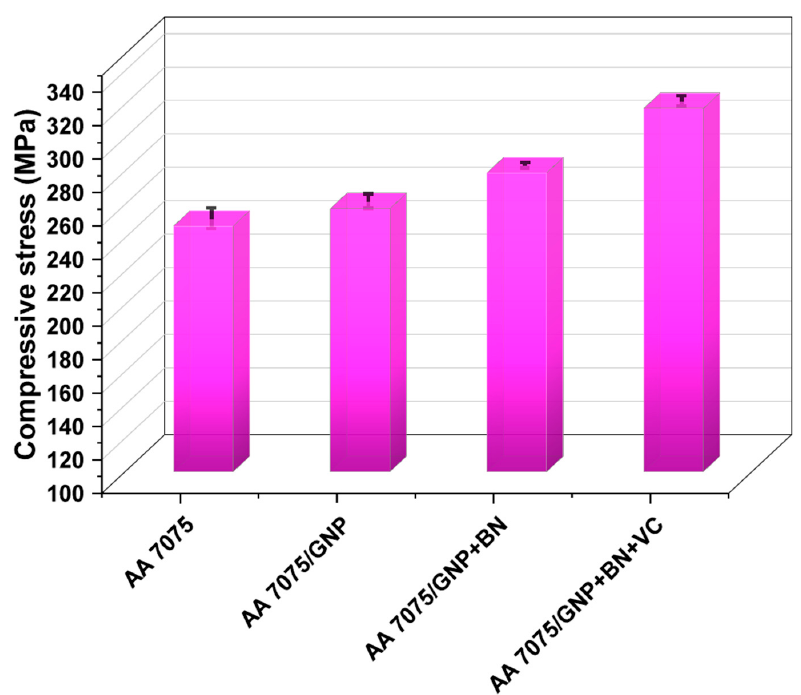
Figure 7. Ultimate compressive